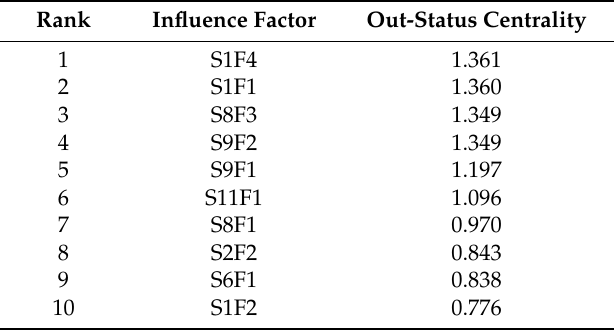
Table 5. The key factor related to out-status